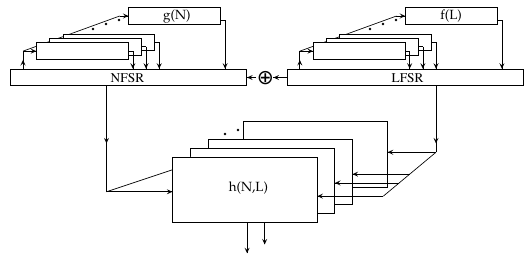
Figure 3: Up to 16x implementation of Grain